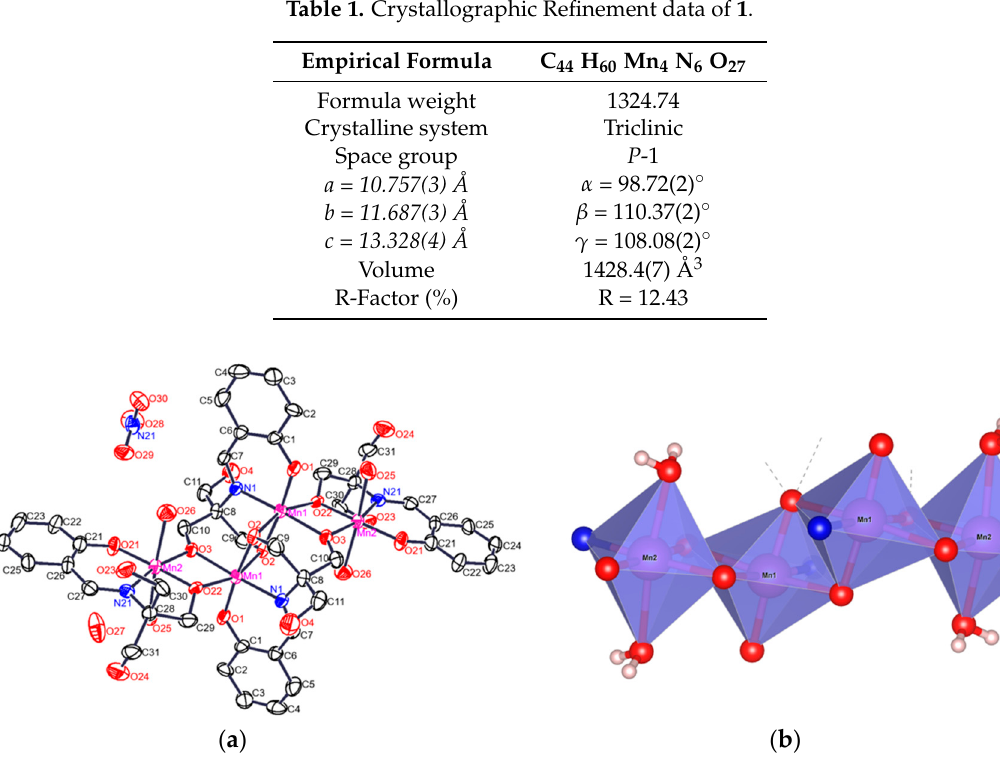
R = 12.43 In Figure 1 the basic nucleus of the crystallographic structure, which denotes all Mn(III) ions according to crystallographic distances (see Computational Details), is shown. Figure 1 shows a primary nucleus [Mn(III)(H 2 L)[Mn(III)(HL)] 2 Mn(III) (H 2 L)]. This molecular nucleus contains four units of [Mn- μ 5 − O, μ 1 − N] where each manganese ion is bonded to four ligands through one phenolic oxygen atom to two phenolato oxygen atoms, which connect it to the other neighboring manganese